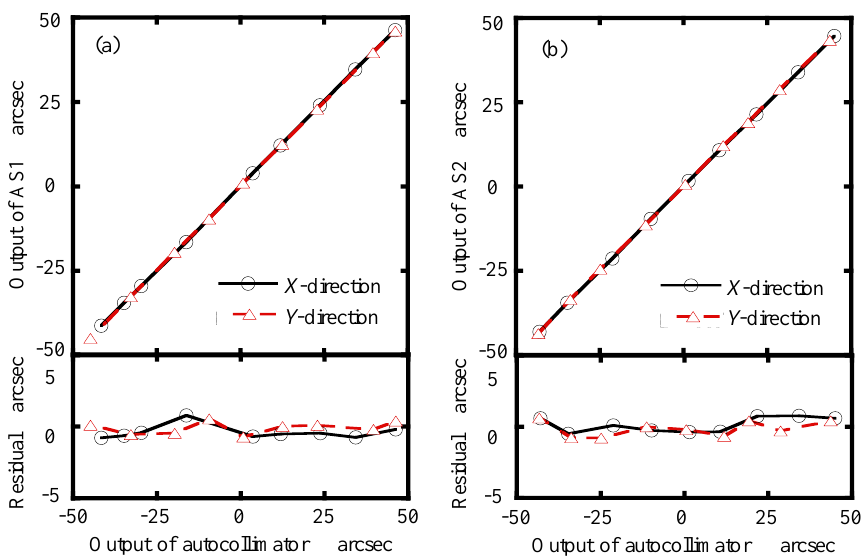
Figure 6. Calibration results of the AS1 and AS2 in the X- and Y-direction: ( a ) AS1, ( b ) AS2. Then, the wavelength of the He-Ne laser was calculated by the RWC ( λ RWC ) and compensator ( λ com ) under the various temperatures. Figure 7 shows the variation of the laser diode wavelength with temperature. The missing measured points correspond to the temperature period when the MCV500 was not in operation. For comparison, the wavelength ( λ ref ) evaluated by the equation, which was proposed in Ref. [7], was also plotted in the figure. As seen from Figure 7, the He-Ne laser wavelength was enlarged with the increase of the temperature. The laser wavelength ( λ RWC ) obtained by the modified wavelength correction equation Eq. (4) was larger than the wavelength